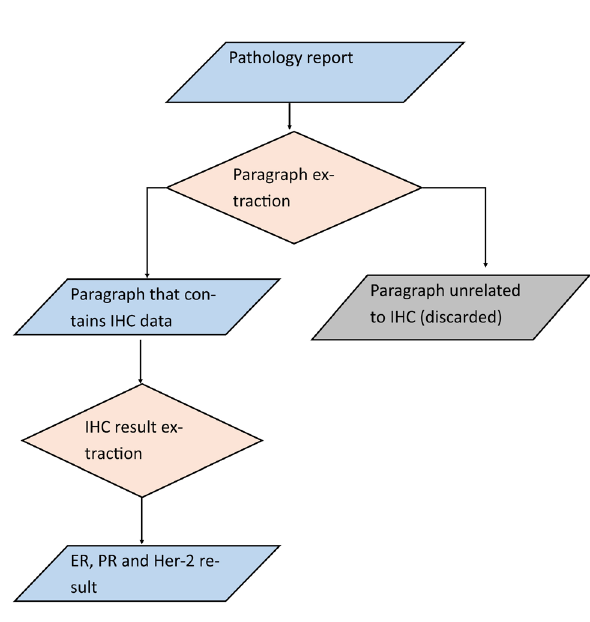
Figure 3: Protocol for mining of hormone receptor